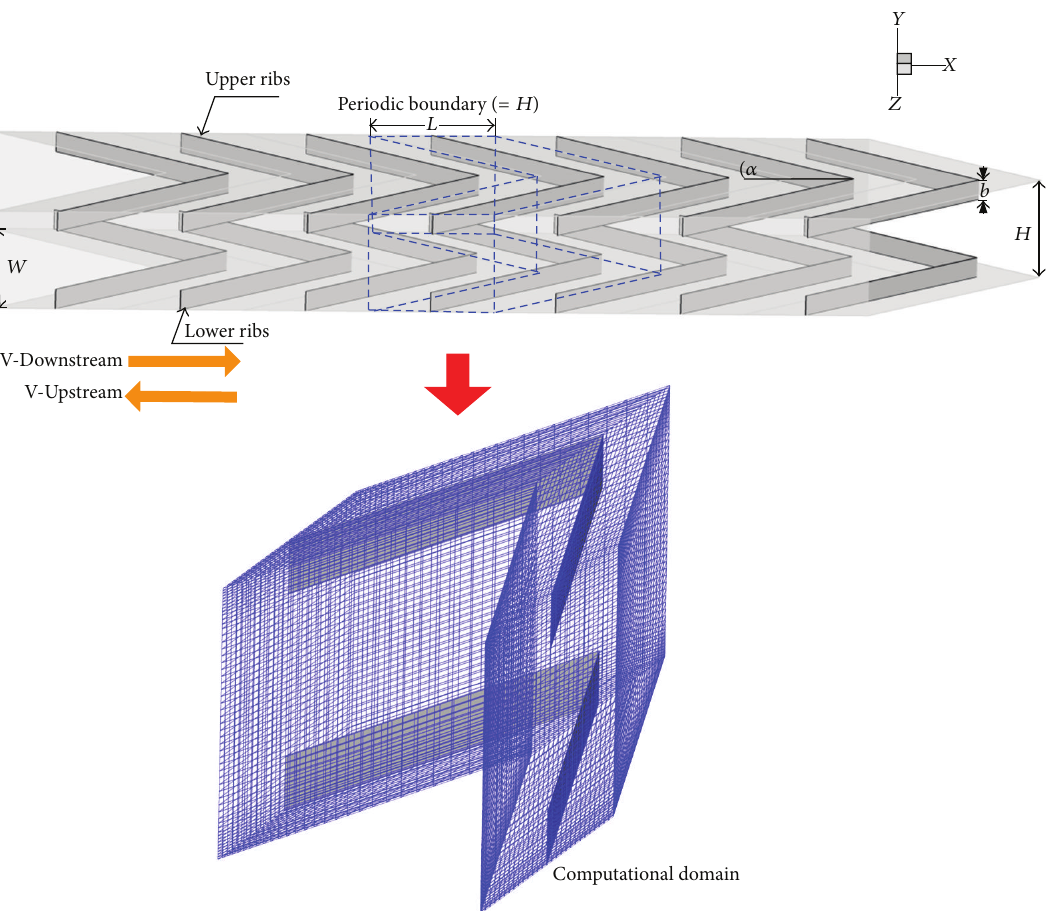
Figure 1: Square duct geometry and computational domain of periodic flow for 20 ∘